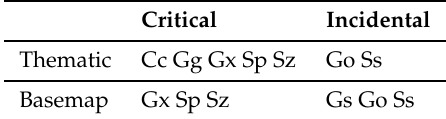
Table 9. Schedule of operators for Hennig’s UK Election